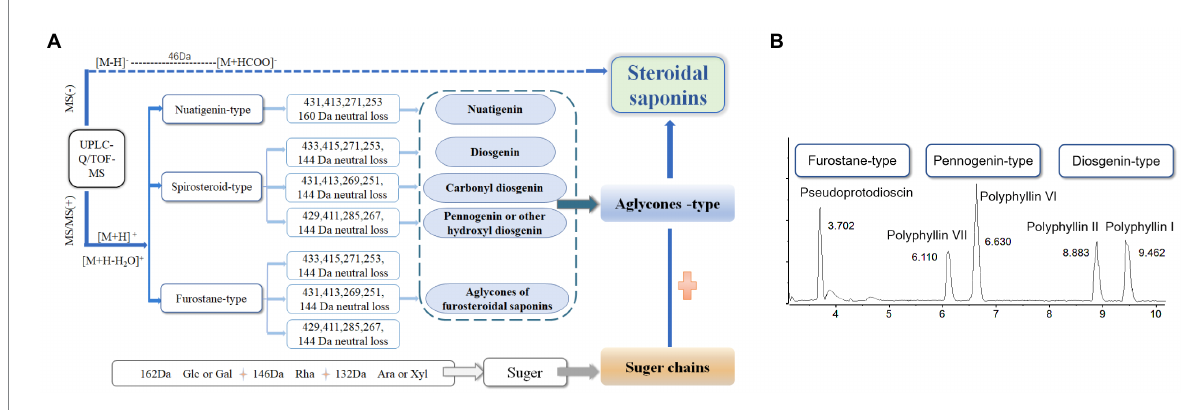
FIGURE 3 Strategy used for characterizing steroidal saponins in Paridis Rhizoma by HPLC-Q/TOF-MS. (A) Chromatographic behavior of steroidal saponins with different configurations. (B) BPC chromatograms of UPLC-MS for reference standards at ESI − .